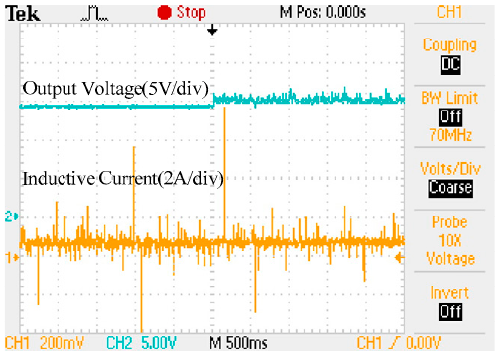
Figure 20. Experimental step-input-voltage waveforms of the output voltage and inductive current under the TSM controller.